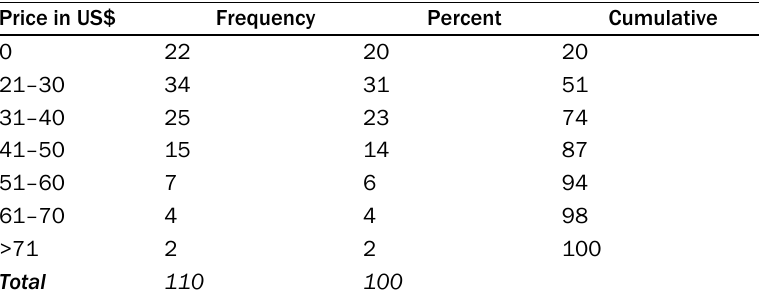
Table 3. Distribution of Willingness to Pay (WTP) Across Price Levels Price in US$